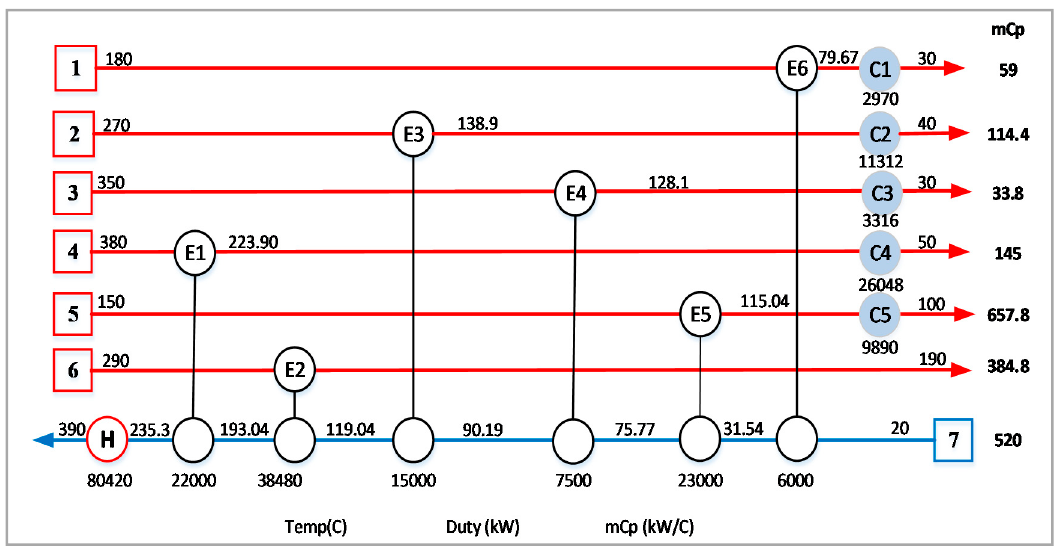
Figure 2. Grid diagram of existing heat exchanger networks (HEN) of crude oil pre-heat train with stream data.